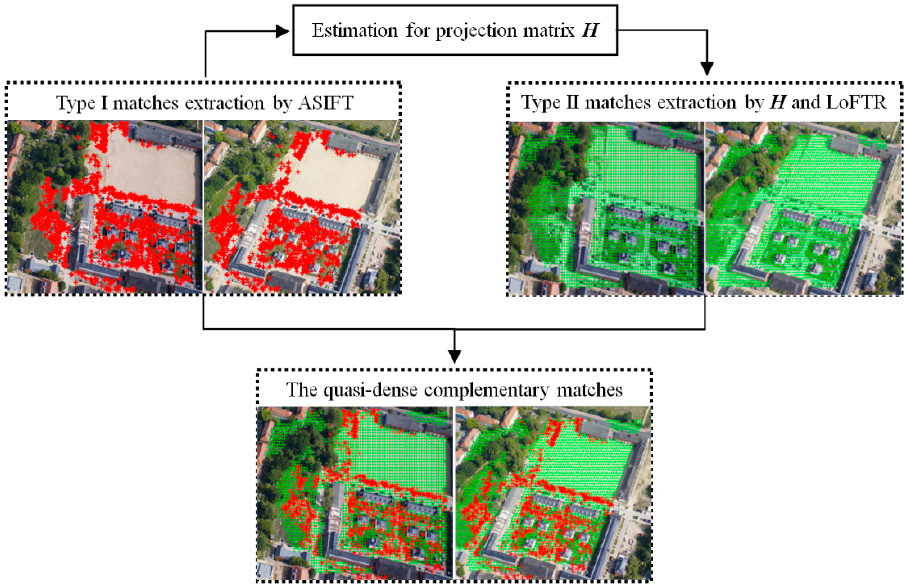
Figure 3. Illustration of quasi-dense matching using complementary features. The type-I (ASIFT) and type-II (LoFTR) matches are represented by red and green points, respectively.